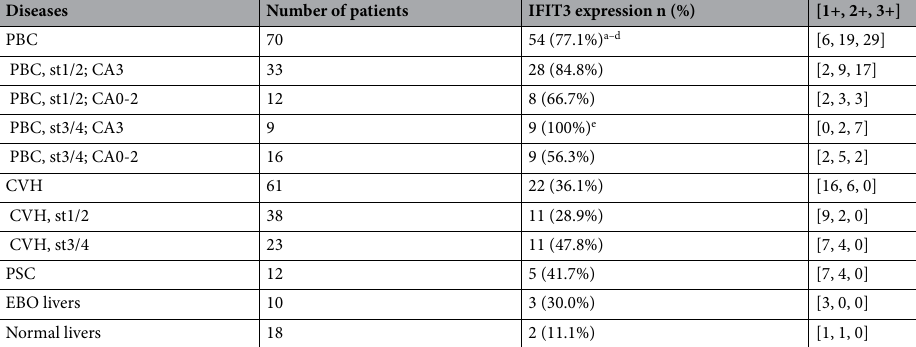
Table 2. Frequency of the expression of Interferon-induced protein with tetratricopeptide repeats 3 (IFIT3) in small bile ducts in primary biliary cholangitis and control livers. PBC, primary biliary cholangitis; CVH, chronic viral hepatitis; PSC, primary sclerosing cholangitis; EBO, extrahepatic biliary obstruction; a, p < 0.01 versus CVH; b, p < 0.05 versus PSC; c, p < 0.01 versus EBO; d, p < 0.05 versus Normal livers; e, p < 0.01 versus PBC, stage 3/4, CA0-2; n, number; n, number; [ ], number of cases showing 1 + (focal, positive cells are detected in one third or fewer portal tracts), and 2 + (moderate, positive cells are detected in small bile ducts of more than one third of portal tracts); 3 + (extensive, positive cells are detected in small bile ducts of more than two thirds of portal tracts).